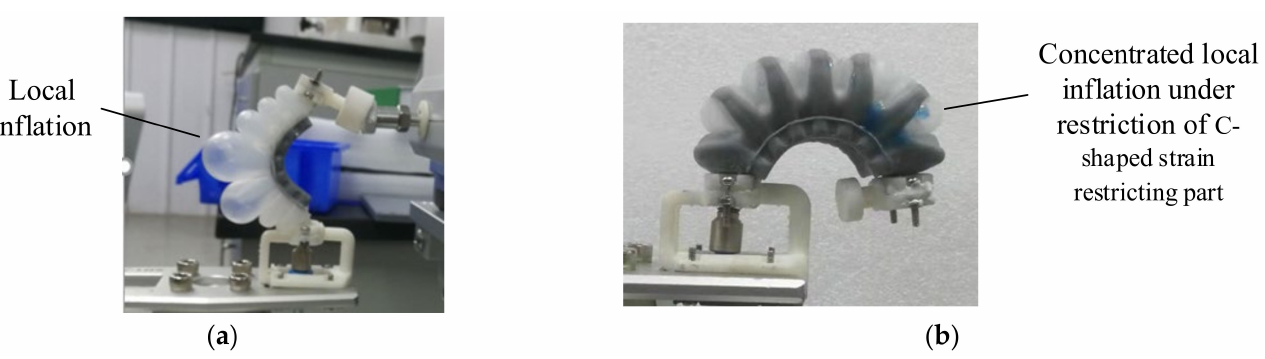
Figure 11. Description of function of hard C-shaped strain-restricting part: ( a ) Local expansion of actuator ballonet without hard C-shaped strain-restricting part. The composition of the shown actuator is “30-30-58”. ( b ) Hard C-shaped strain-restricting part is introduced to the actuator, making local expansion concentrate in the direction favorable for bending. The composition of the shown actuator is